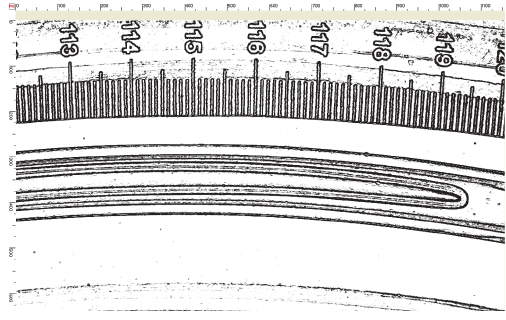
Figure 17: Contrast adjustment.